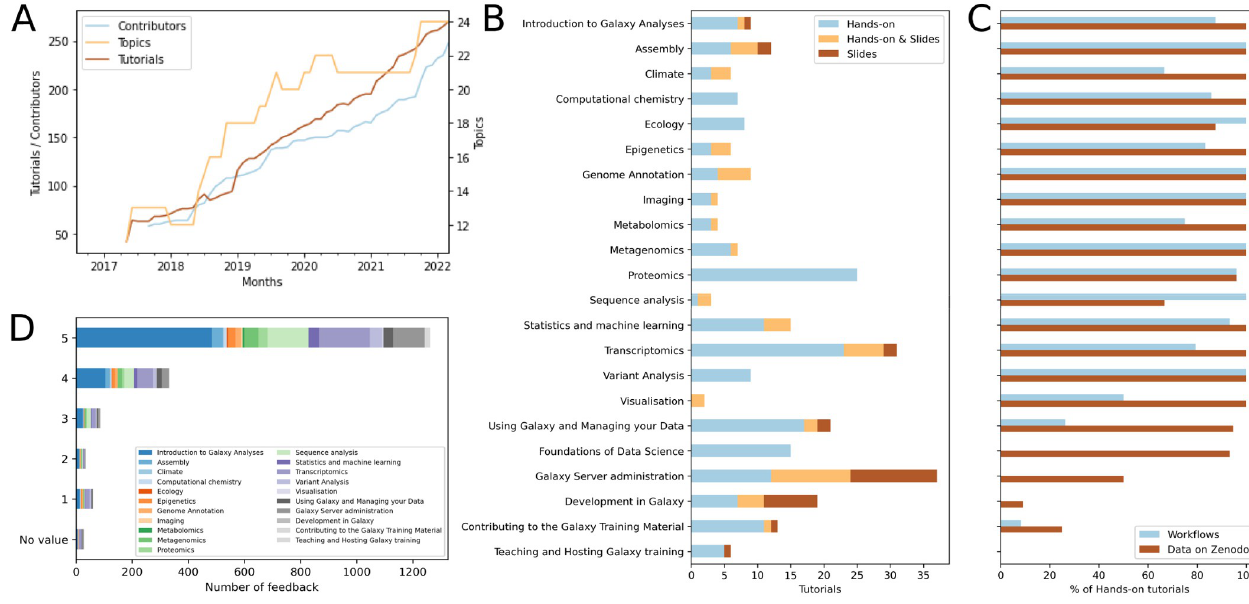
Fig 2. Content of material available on the GTN and feedback from learners. (A) Evolution of number of topics, tutorials, and contributors over the months between 2017 and 2022. (B) Number and type of tutorials per topics available on the GTN on April 2022. The latest statistics are publicly available from https:// training.galaxyproject.org/stats. (C) Type of supporting materials for tutorials per topics available on the GTN on April 2022. (D) Score of the embedded feedback in the tutorials per topics. Three questions are asked in the form: “How much did you like this tutorial?” (from 1 (bad) to 5 (great)), “What did you like?”, “What could be improved?”. The latest feedback results are publicly available from https://training.galaxyproject.org/feedback.